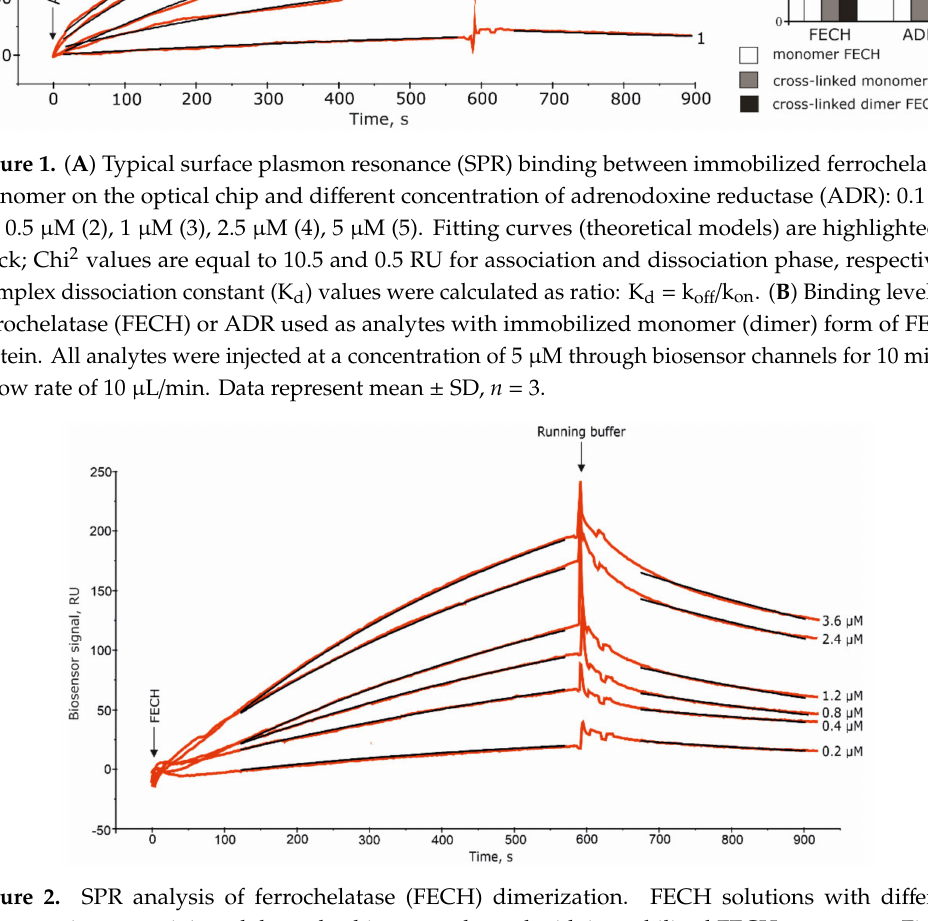
Figure 2. SPR analysis of ferrochelatase (FECH) dimerization. FECH solutions with di ff erent concentrations were injected through a biosensor channel with immobilized FECH monomers. Fitting curves (theoretical models) are highlighted in black; Chi 2 values are equal to 0.3 and 1.0 RU for association and dissociation phase, respectively. Complex dissociation constant (K d ) values was calculated as ratio: K d = k o ff / k on